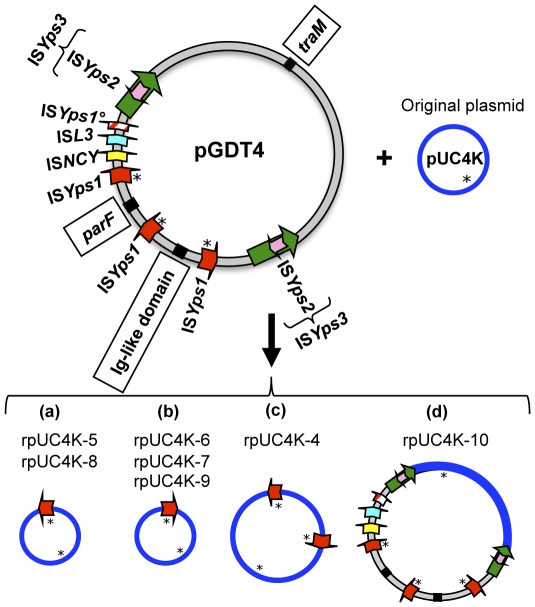
Schematic representation of seven recombinant pUC4K molecules recovered from transconjugants.Ten transconjugants resulting from the co incubation of 637(pUC4K) and 637-NalR were analyzed. The donor plasmid pGDT4 harbors two copies of ISYps1 in direct orientation and one copy in opposite direction, two copies of ISYps3 transposon including ISYps3 and ISYps2 transposases, one ISL3 and one ISNCY. ISYps1° is a truncated copy of ISYps1. Stars indicate XhoI restriction sites. Genes used to search by PCR for the presence of inter-ISYps1 regions are boxed.